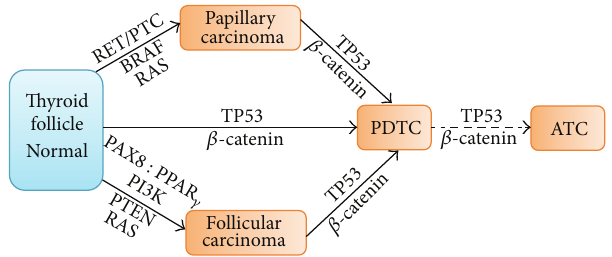
Figure 1: Poorly differentiated thyroid carcinomas (PDTCs) can develop de novo or from papillary or follicular carcinomas, through genetic alterations, possibly progressing into anaplastic thyroid carcinomas